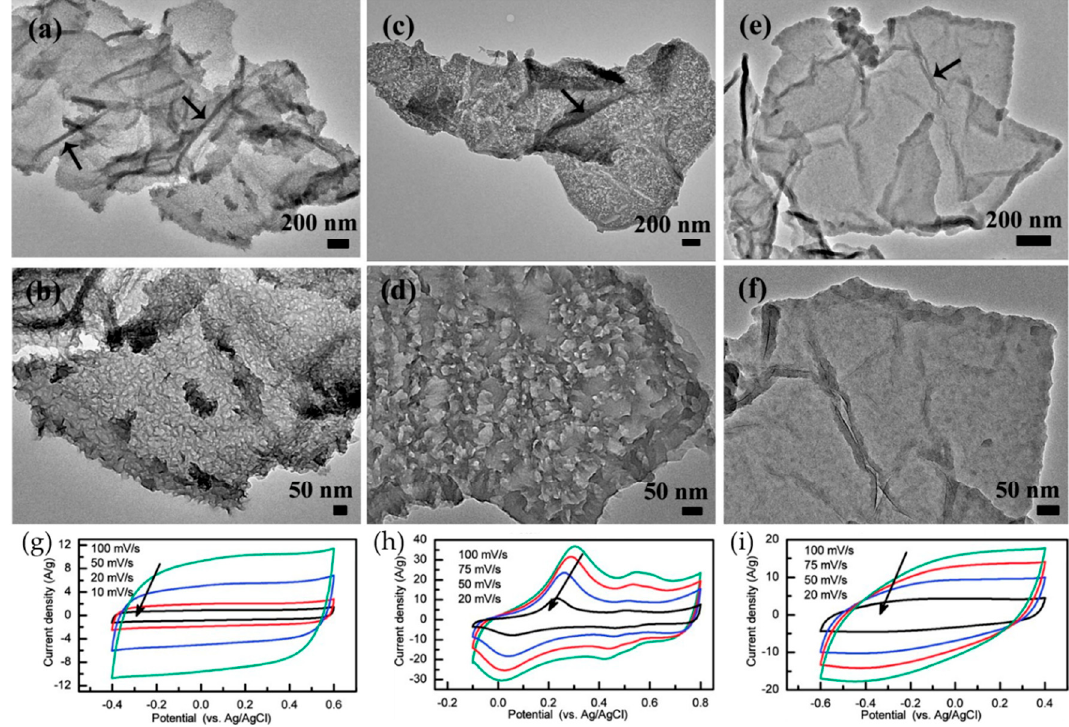
Figure 9. TEM images of rGO-PEDOT ( a , b ), rGO-PANi ( c , d ), and rGO-PPy ( e , f ); CV curves of rGO-PEDOT ( g ), rGO-PANi ( h ), and rGO-PPy ( i ). Reproduced with permission from [94]. American Chemical Society (2012).